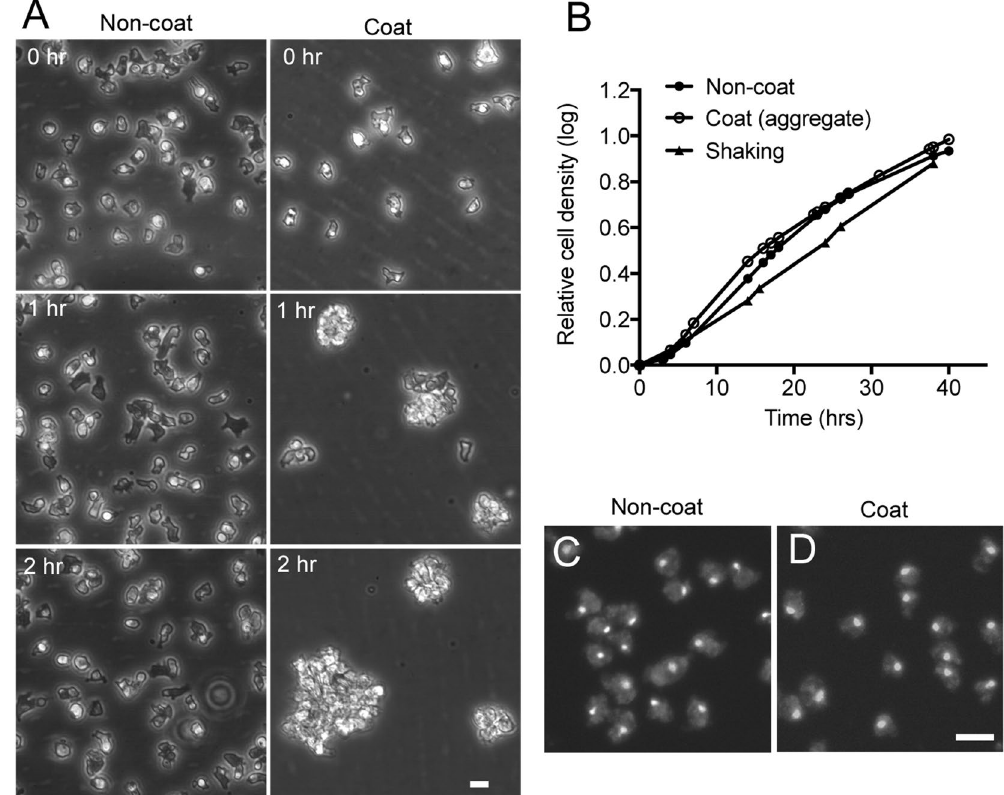
Figure 2. Cells can divide in multicellular aggregates. ( A ) When cells were cultured in the Lipidure-coated plastic dish, they gradually adhered to each other to form multicellular aggregates within 1–2 h (right column), whereas the cells adhered to the substratum separately on the non-coated surface (left column). ( B ) Cell growth rate under three different conditions: on a non-coated surface (closed circles), on a coated surface (cells formed multicellular aggregates, open circles), and in shaking culture (closed triangles). The cells grown in shaking culture were cultured in a conical flask at 150 rpm. A small aliquot of the cell culture was taken at indicated time, dissociated by pipetting, and then the cell density was counted by a hemacytometer. The growth rates were almost equal in all conditions. ( C and D ) Nuclei of the cells after culture in different conditions: on a non-coated surface ( C ) and on a coated surface ( D ). The cell aggregates were dissociated into single cells by pipetting, fixed with a fixative and then stained with DAPI for fluorescence microscopy. Note that most of the cells had a single nuclei in both conditions, suggesting that the cells divide properly in the multicellular aggregates. Bars, 10 µ